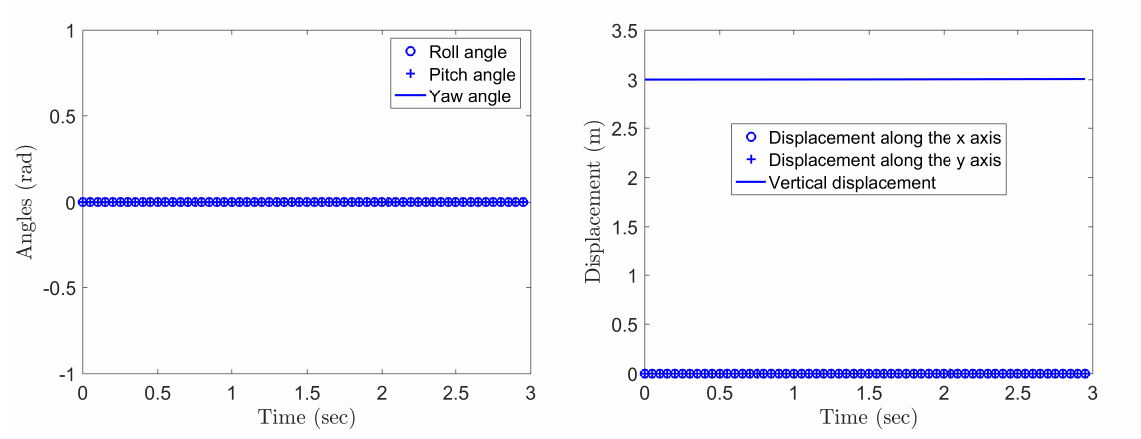
Figure 6. Trajectory of a quadrotor drone in Experiment 1.